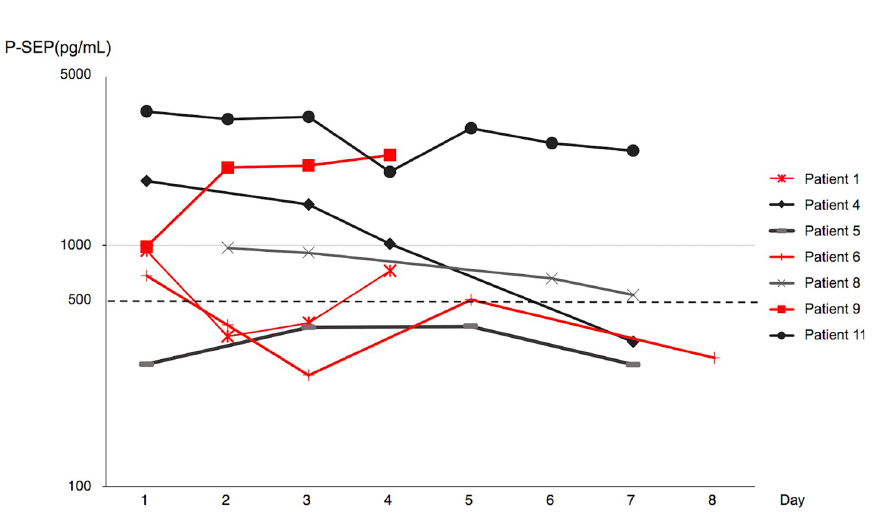
Fig 2. Changes in the presepsin levels in the first week of fungal bloodstream infection. The P-SEP levels increased or increased again after an initial drop in patients who had poor improvement (red lines). In patient #1, the P-SEP levels decreased on day 2 but increased again with bacterial infection on days 3 and 4. In patient #6, P-SEP levels decreased on days 2 and 3, increased again during a catheter-related bloodstream infection on day 5, and returned to normal after removal of the catheter on day 7. Patient #9 died of fungemia on day 4 and had continuous increment in P-SEP levels.